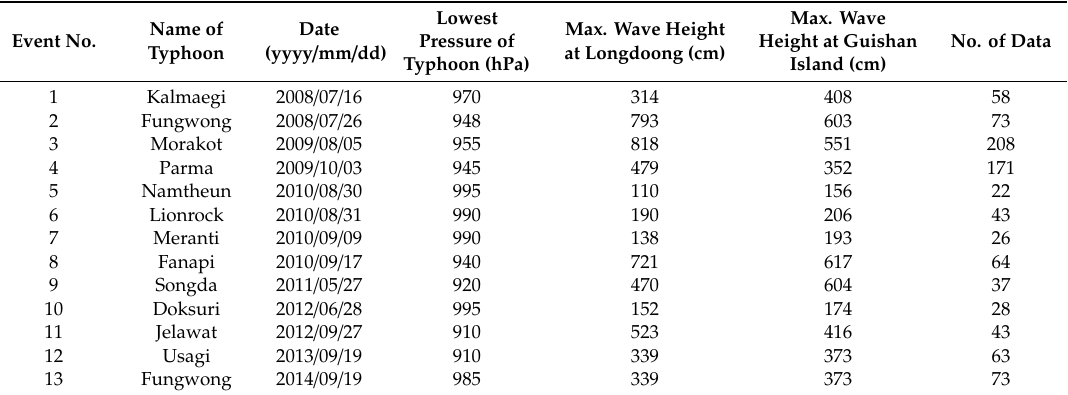
Table 1. Typhoon events and wave